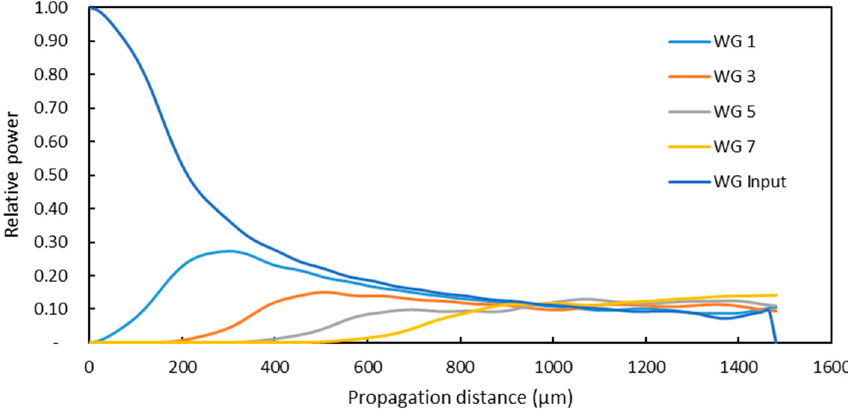
Figure 6. Relative power along the propagation distance for each waveguide.